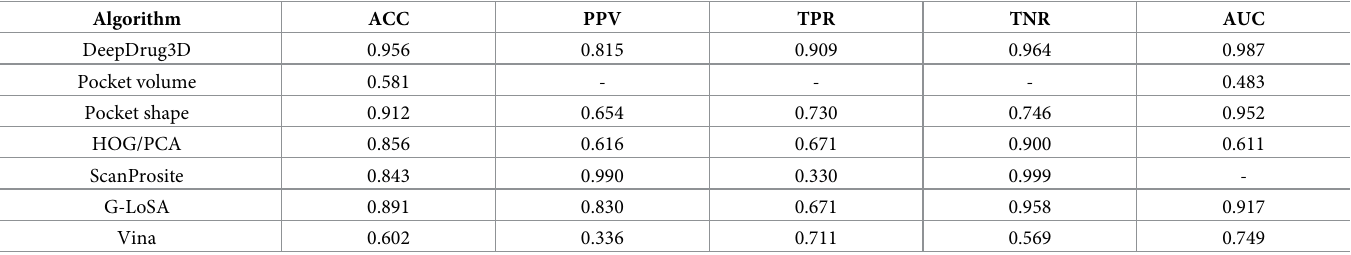
Table 2. Performance of various algorithms to classify heme-binding sites. DeepDrug3D is compared to volume- and shape-based approaches, a classifier employing the histogram of gradients with principal component analysis (HOG/PCA), pocket matching with G-LoSA, molecular docking with Vina, and sequence signature detection with ScanProsite. The performance is assessed with the accuracy (ACC), precision (PPV), sensitivity (TPR), specificity (TNR), and the area under the curve